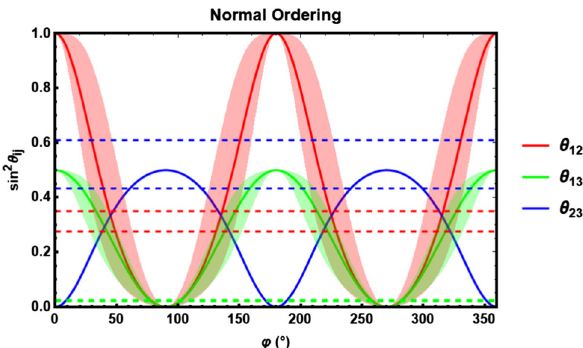
Fig. 4 Sine squared of the three PMNS mixing angles as a function of the free parameter ϕ . The dashed lines show the experimental bounds at 3 σ on each of the sines for NO. The bounds for IO are not perceptibly different In Fig. 4 the solid lines represent the exact prediction for the angles as shown in Eq. (4.31). There is no value for